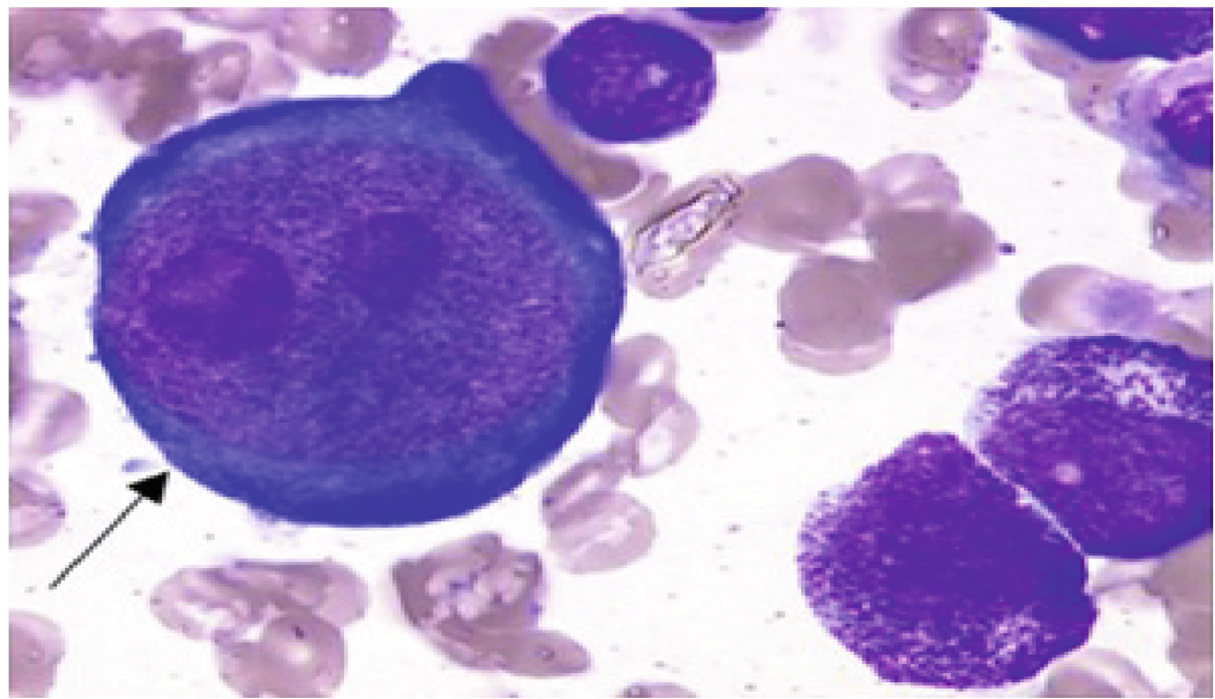
Figure 1: May – Grünwald – Giemsa staining of bone marrow aspirate showing the classical feature of PRCA, namely, a red inclusion in the nucleus of giant pronormoblasts (arrow)